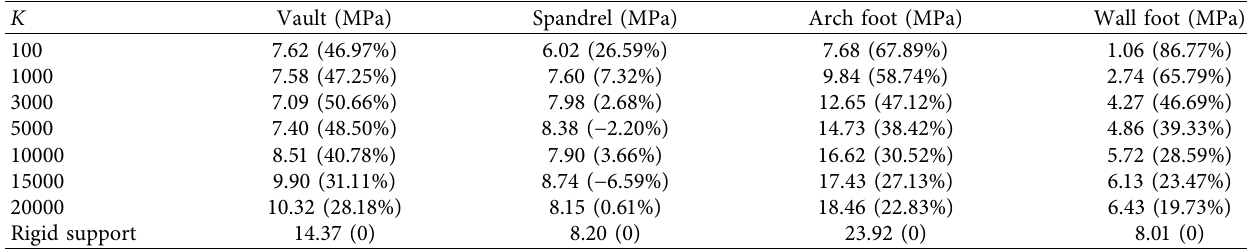
Figure 9: Time history curve of study point pressure. (a) Vault. (b) Spandrel. (c) Arch foot. (d) Wall Table 7: Peak pressure values at study points.